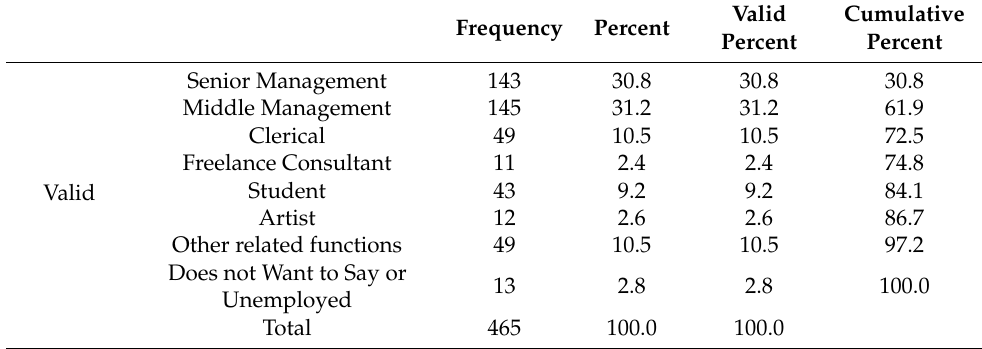
Table 5. Role/position in the